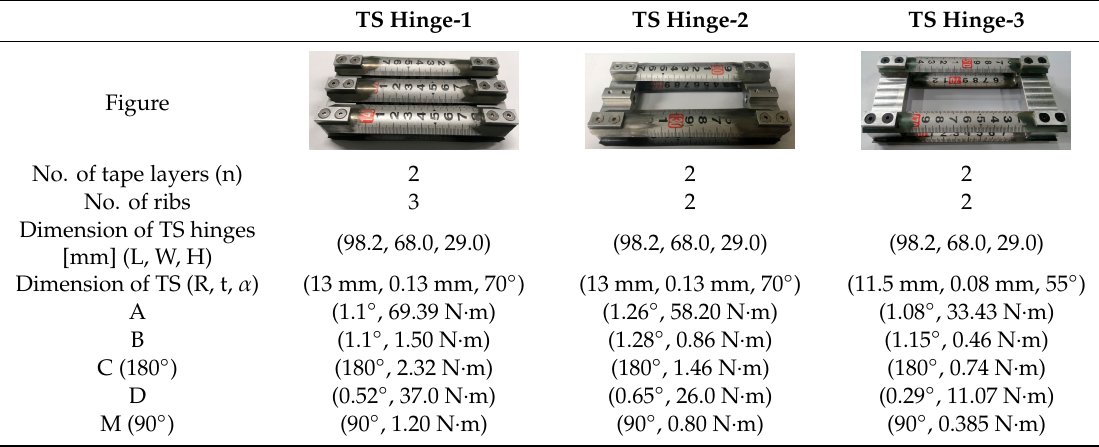
Table 1. Specification of three types of TS hinges and mechanical characteristics.